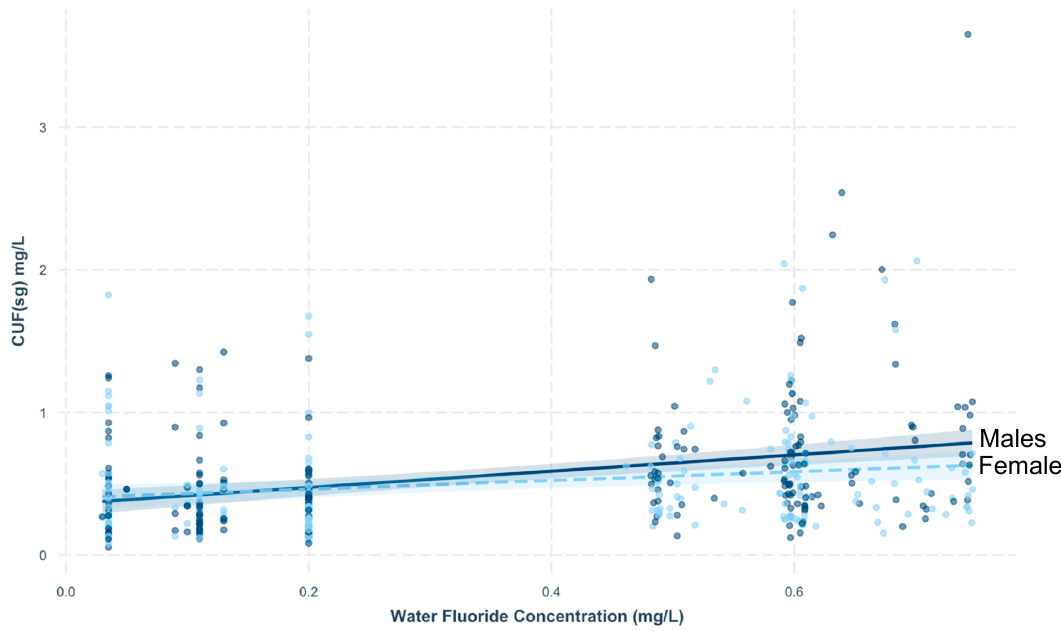
Figure 1. Associations of water fluoride concentration with CUF SG concentration in the MIREC cohort according to sex.